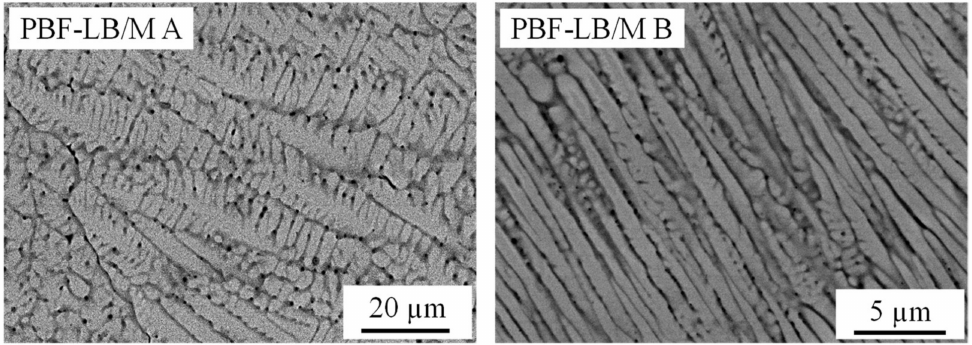
Figure 6. Backscattered electron (BSE) images of the microstructure of sample PBF-LB/M A ( left ) and sample PBF-LB/M B (right) .